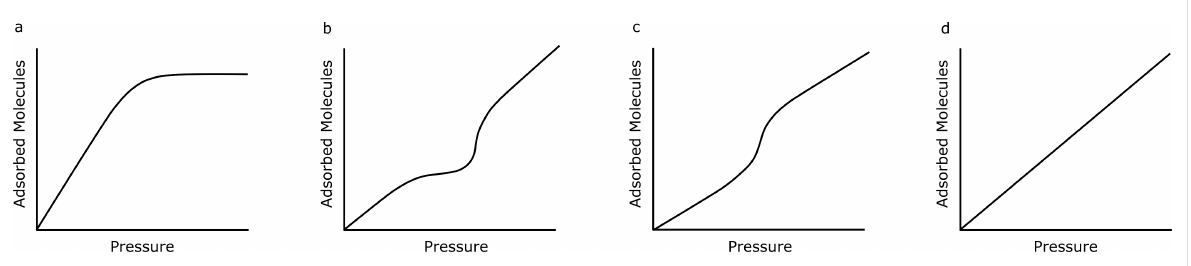
Figure 4: FEBID adsorption isotherms extracted from FEBID frequency maps shown in Figure 3d–f. (a) Type I (Langmuir), (b) Type II (BET), (c) Type III, and (d) Linear (MTL